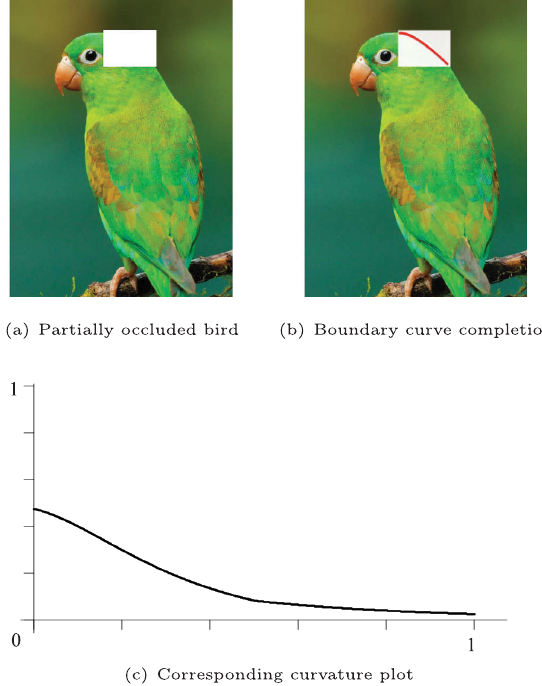
Fig. 11 Bird silhouette completion using Algorithm 2.